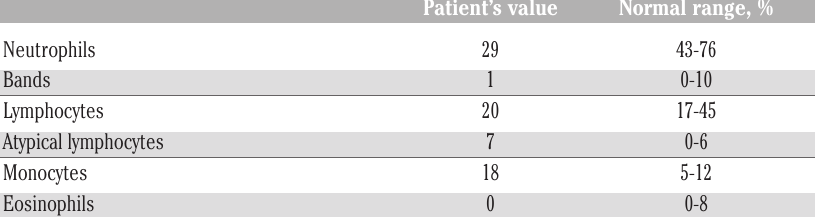
Table 2. Peripheral blood differential count.